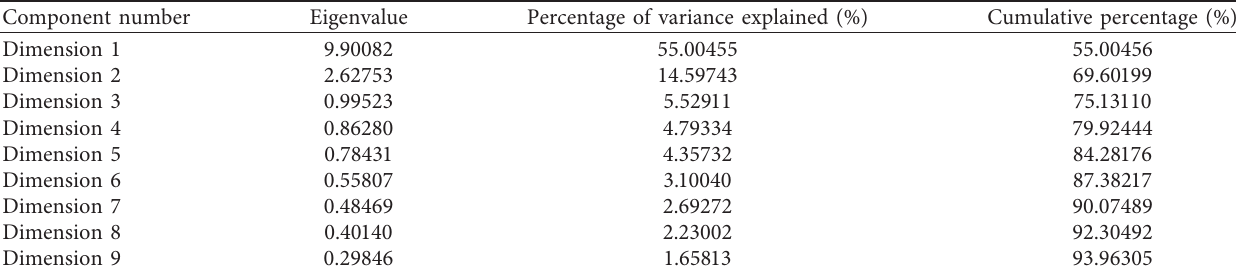
Table 2: Eigenvalues of components and percentage of variability explained in the data.